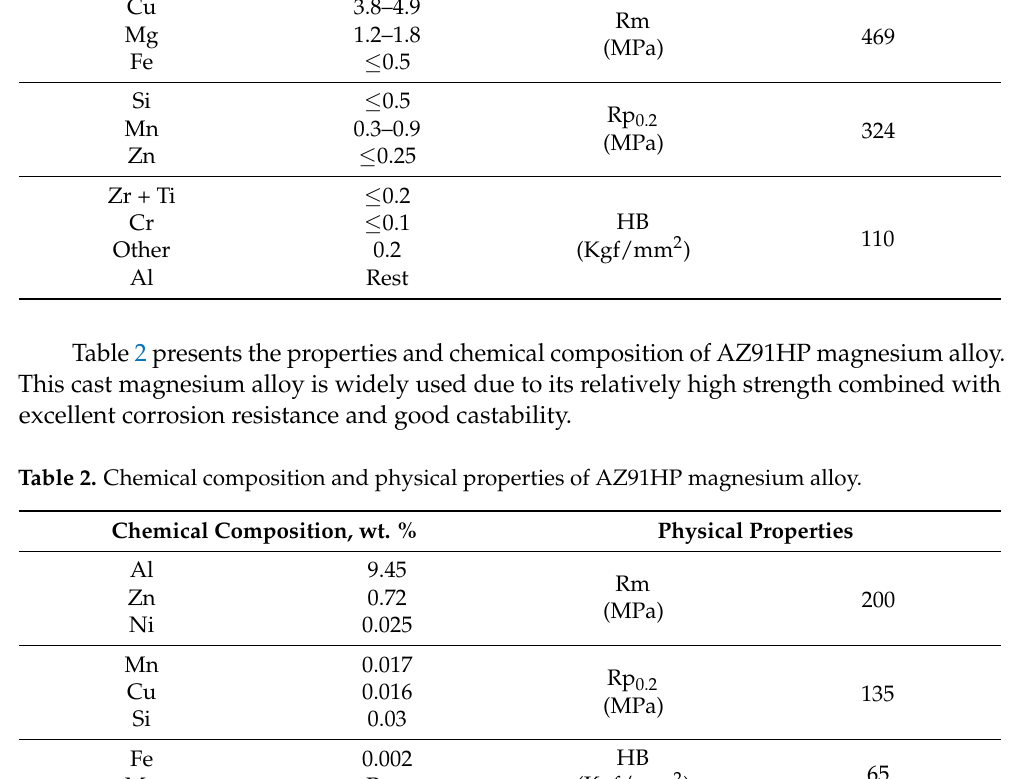
Table 1. Chemical composition and physical properties of EN-AW-2024 T351 aluminum alloy. Chemical Composition, wt. %